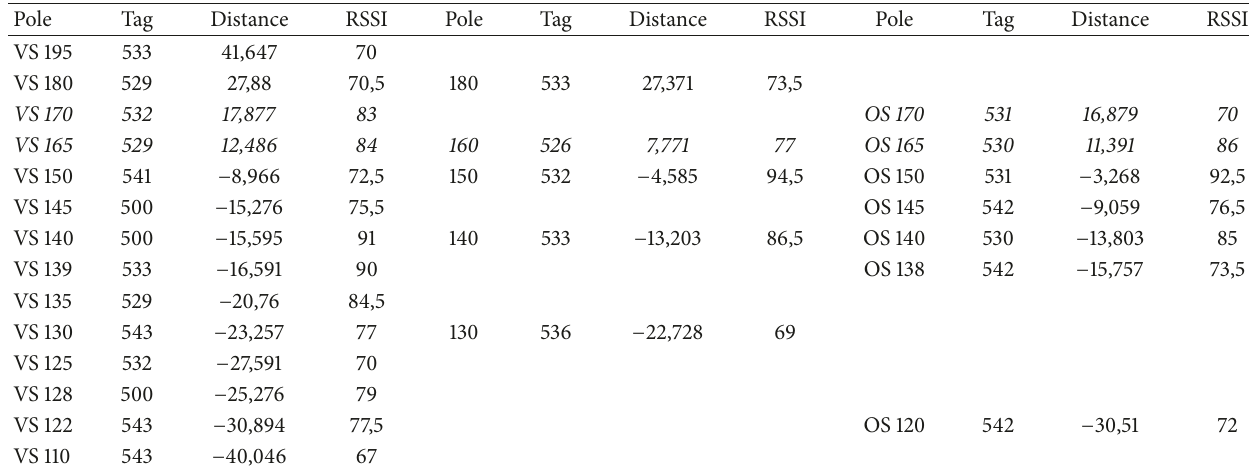
Table 3: Compiled table of antenna 5